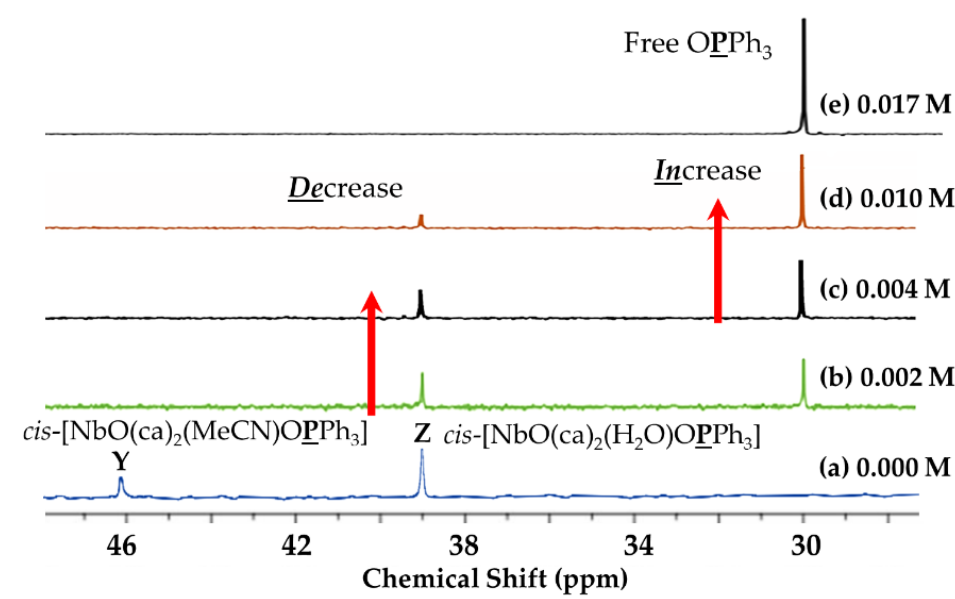
Figure 3. Stacked plot of 31 P{ 1 H} NMR spectral change which is influenced by the addition of water to the starting complex ( a ), cis -[NbO(ca) 2 (H 2 O)OPPh 3 ] − (0.013 M), (( b – e ), 0.002, 0.004, 0.010 and 0.017 M), respectively in acetonitrile (CD 3 CN) at 25 °C, showing the decreasing cis -[NbO(ca) 2 (MeCN)OPPh 3 ] − ( Y ), and cis -[NbO(ca) 2 (H 2 O)OPPh 3 ] − ( Z ), and increasing liberated free OPPh 3 (signal at 29.9 ppm).